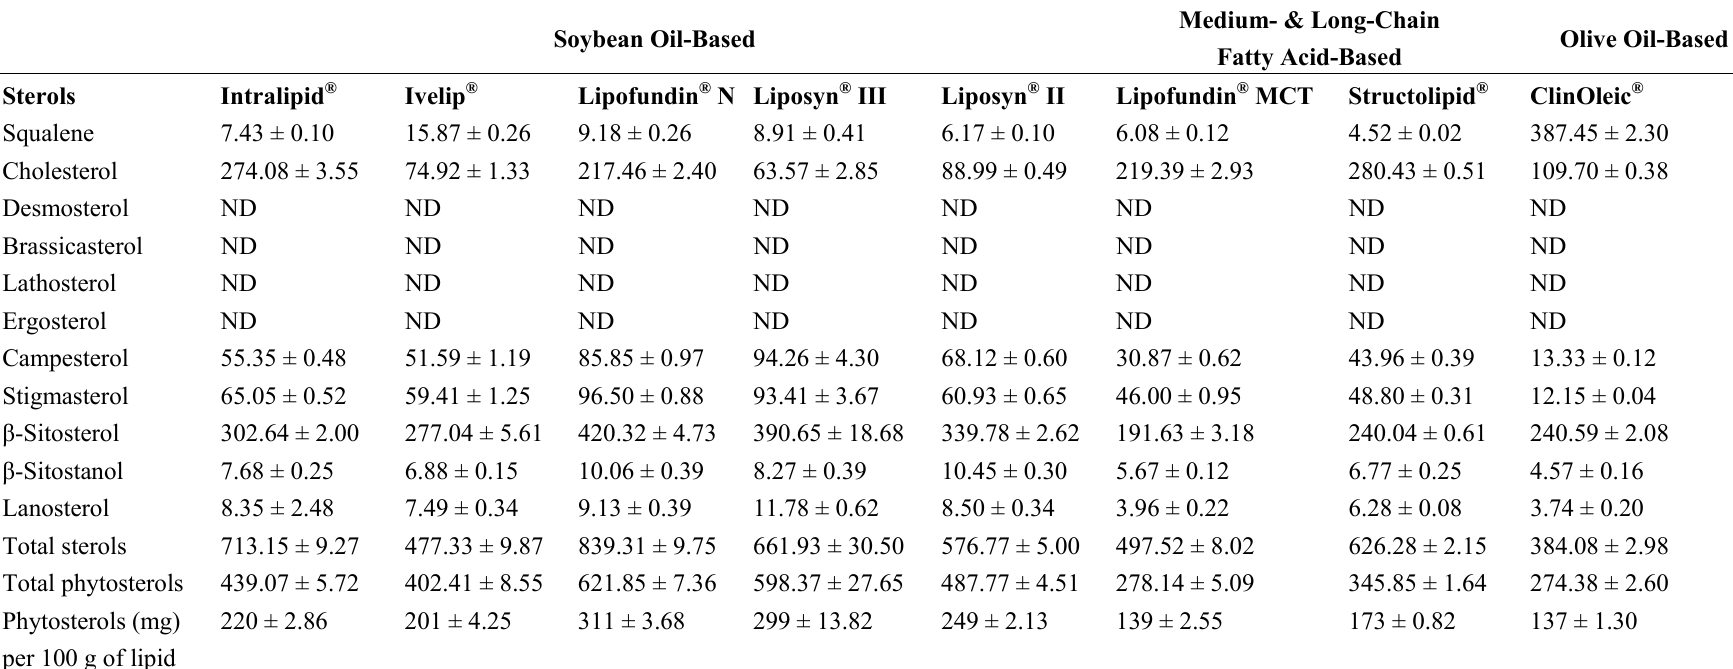
Table 4. Sterol composition of parenteral lipid emulsions (µg/mL ± SD) *. Soybean Oil-Based